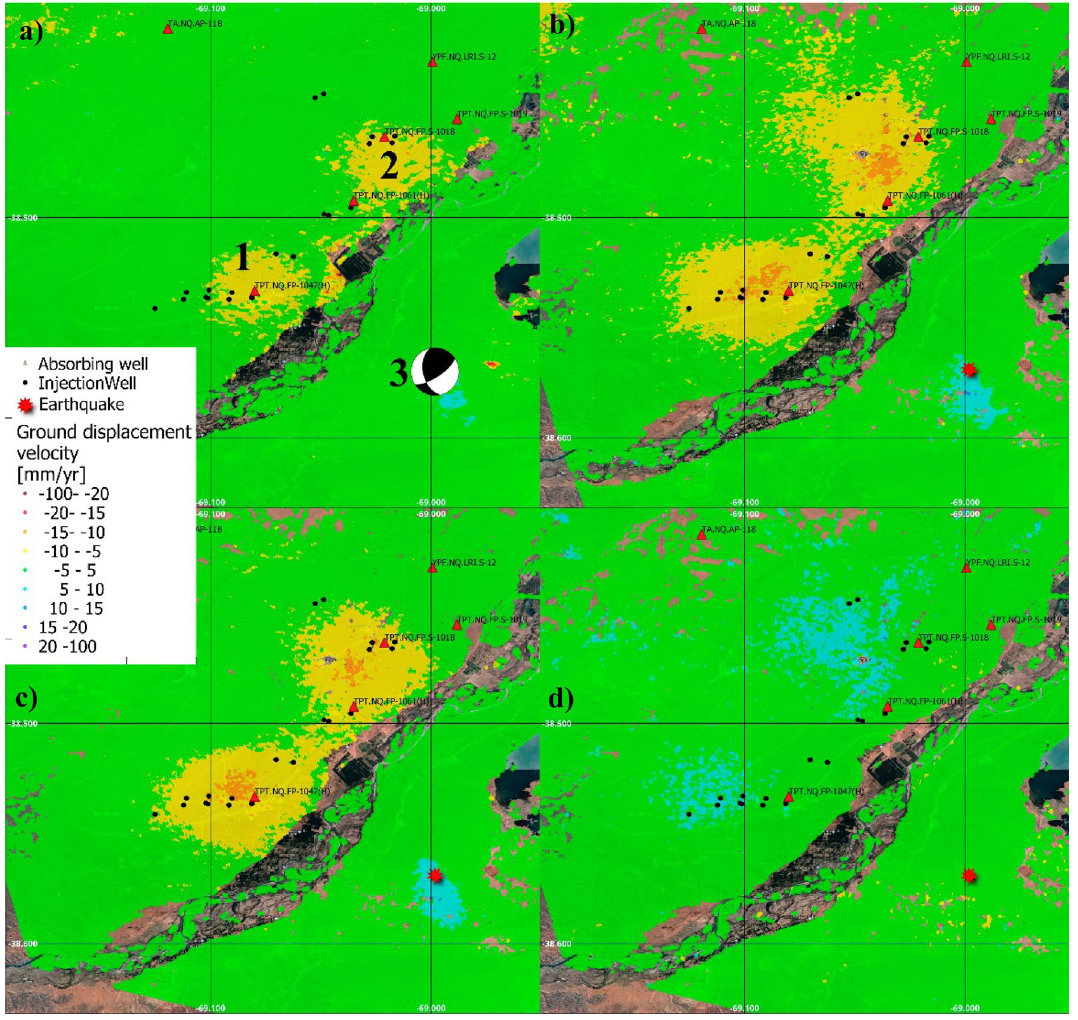
Figure 2. Ground displacement velocity maps obtained from ascending ( a ) and descending trajectory ( b ) superimposed to a Google satellite image. ( c ) and ( d ) Show the ground displacement vertical and West–East component respectively. The analysed period spans from January 2017 to December 2020. Main deformation zones labelled 1 and 2 correspond to areas with high concentration of wells, 33 and 25 respectively. Absorbing Wells (red triangles) indicate the location of wastewater disposal wells. Red star indicates the main area affected by the ML 4.9, 2019 March 7 earthquake and 3 shows its Global Centroid Moment Tensor (GCMT) focal